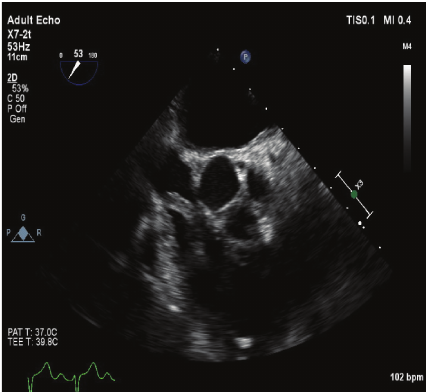
Figure 2: TEE image (short axis view at the aortic valve level) showing the thrombus.